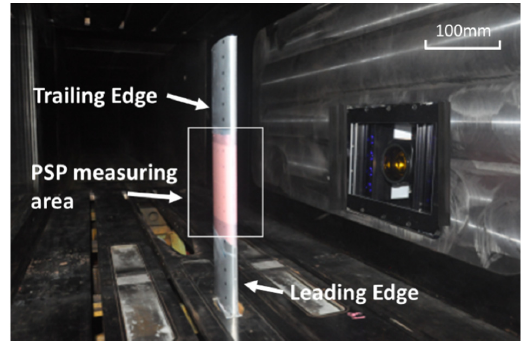
Figure 10. Model test section. PSP, pressure-sensitive paint.